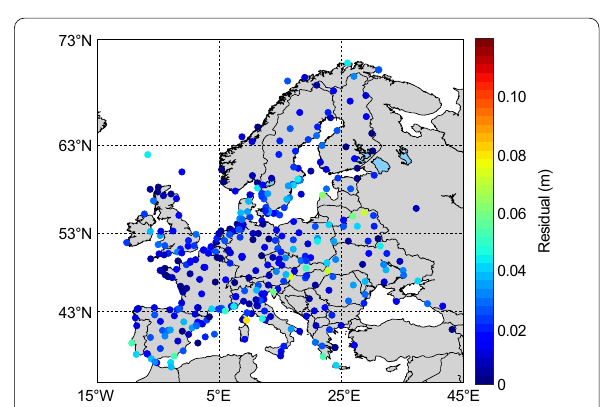
Fig. 3 The ZWD regional modelling residuals for each reference